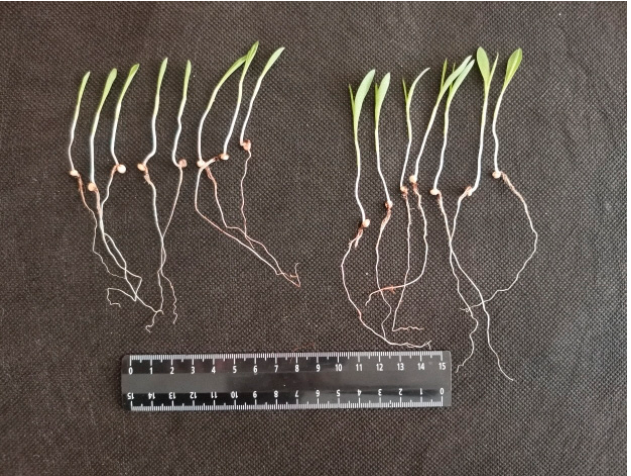
Figure 1. Photographs of randomly selected young shoots of sorghum on the 5th day after seed treatment ( left —control, right —experiment (seeds were soaked in water with activated glow discharge plasma for 5 h)).